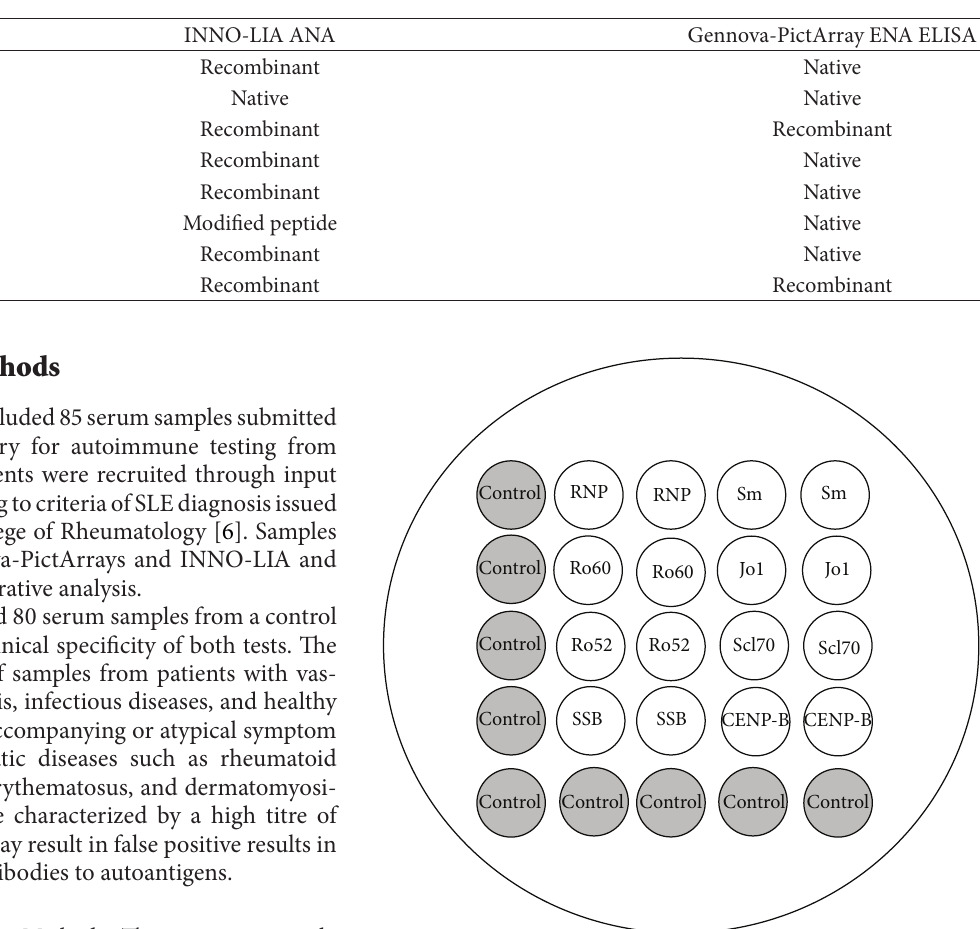
Table 1: Source and composition of antigens in INNO-LIA and Gennova-PictArrays.